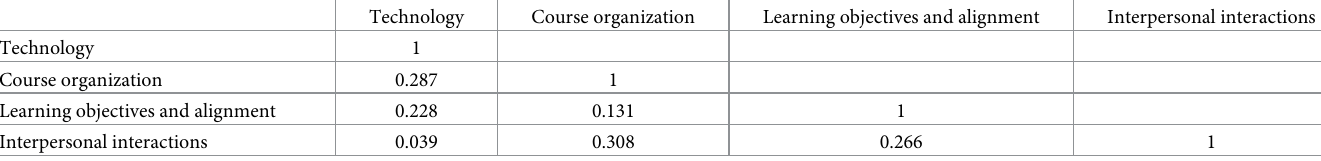
Table 3. Pairwise Pearson’s correlation of course design